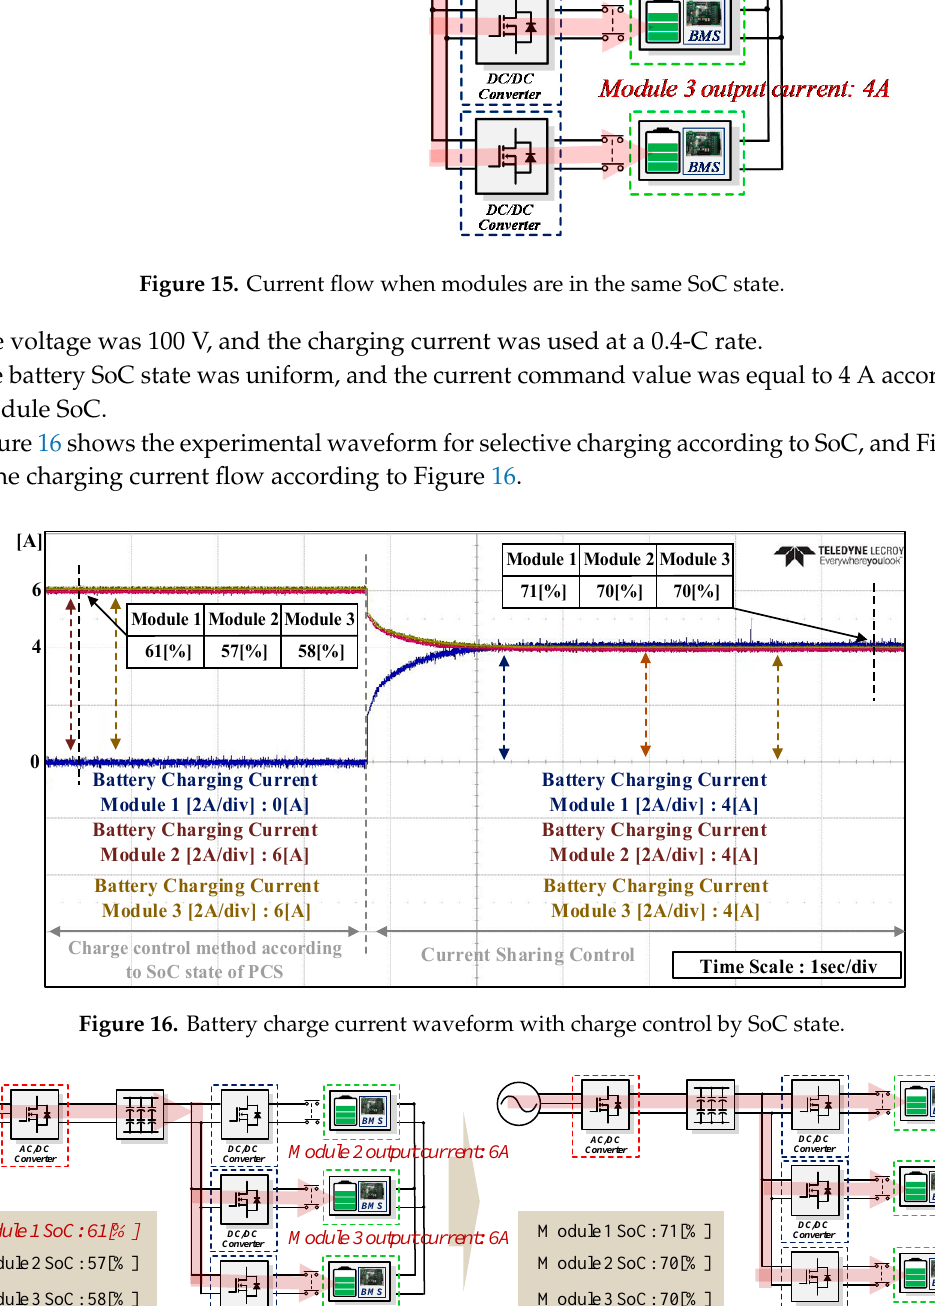
Figure 14. Battery charging voltage, the current waveform of ESS.